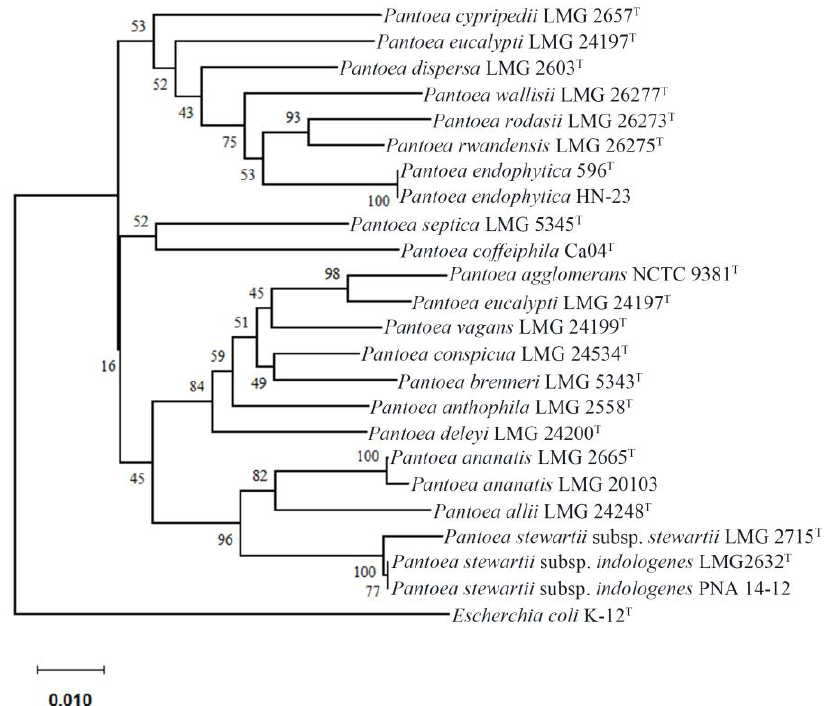
Figure 1. Neighbor-joining phylogeny of Pantoea type strains, based on a concatenated dataset composed of partial atpD , gyrB , infB and rpoB genes using maximum composite likelihood. Nodes show the result of 1000 bootstrap replicates.